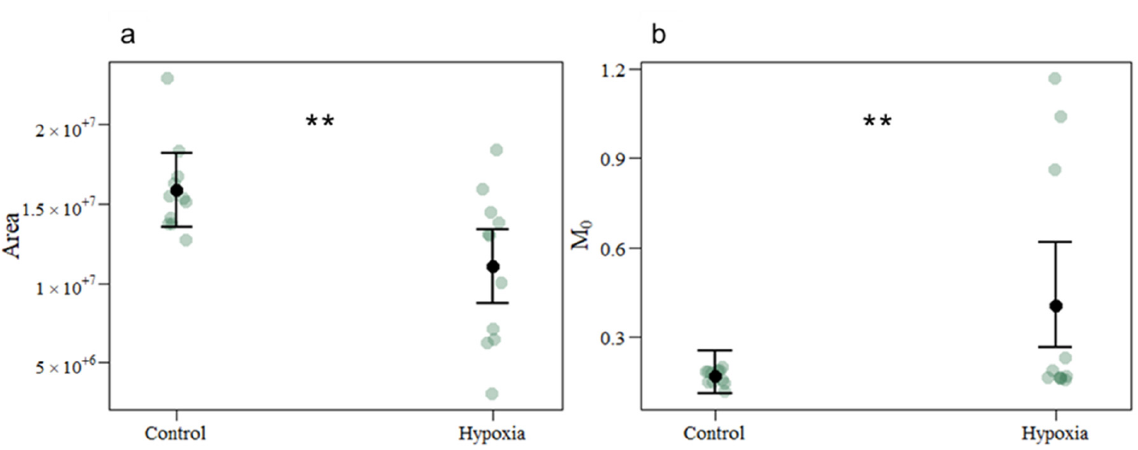
Figure 1. Extracted fluorescence parameters in coral fragments exposed to control and hypoxic conditions. ( a ) Oxidized quinone pool size (Area) and ( b ) net rate of PS II reaction centres closure (M 0 ). The values represent mean and standard deviation, asterisks indicate significant differences between the treatment groups at: p < 0.01 (**) (control n = 11; hypoxia n = 11). The n denotes the number of coral samples assessed in the analysis. CI from the model and each measurement point are represented.